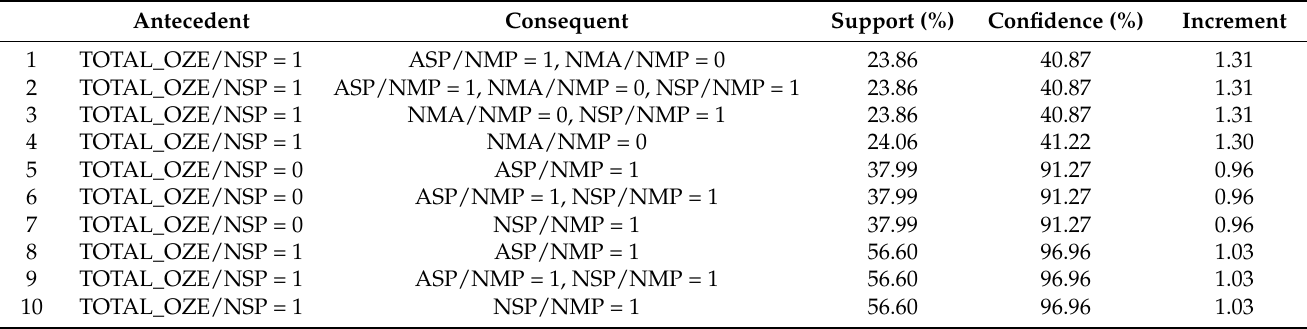
Table 5. Selected association rules for the predecessor TOTAL_OZE/NSP (N = 2477). Antecedent Consequent Support (%) Confidence (%)